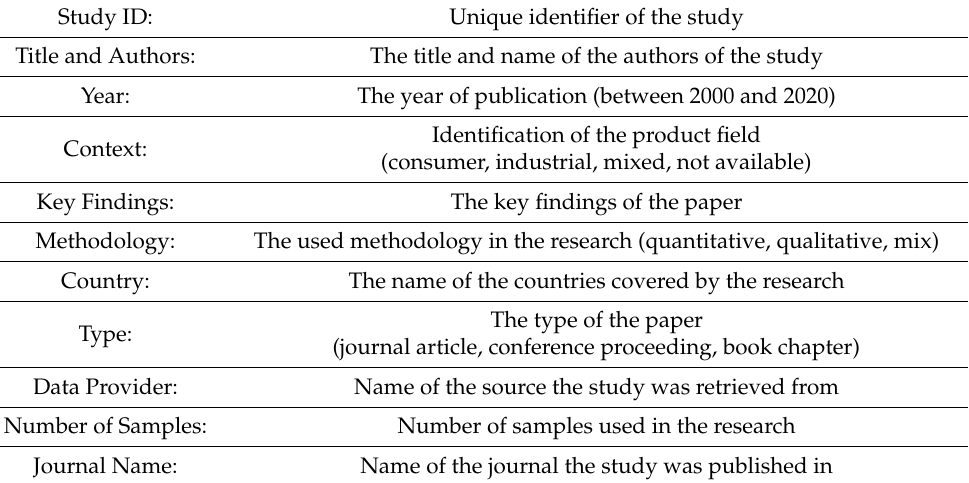
Table 5. Data extraction for primary studies.